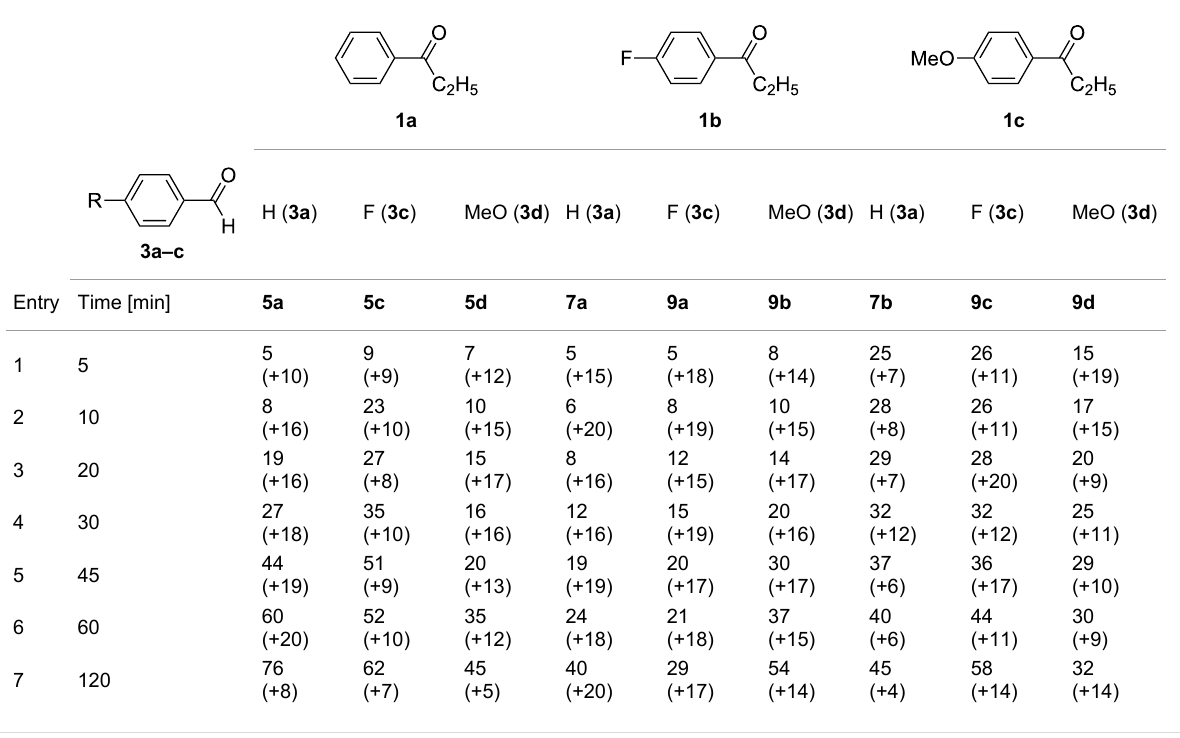
Table 7: Time dependent domino aldol reactions of different aldehydes and ketones having H, F and MeO units at para -position of phenyl units using ZrCl 4 . Yields are in % and numbers in brackets are for mono aldol products (reaction time: 2 h, reaction temperature: 25 °C).